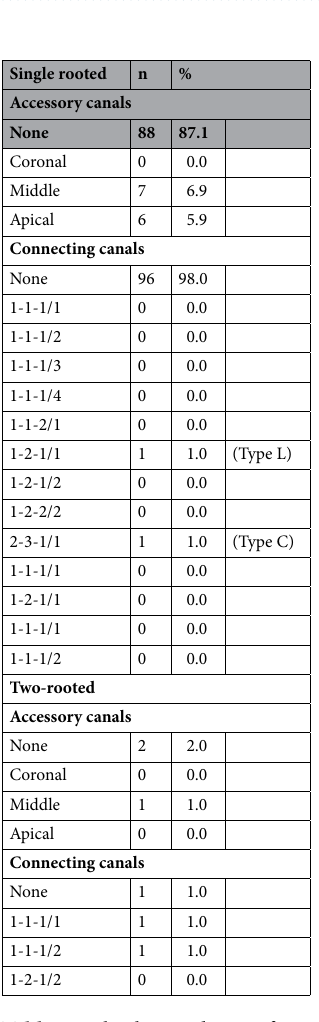
Table 3. Absolute and mean frequency of connecting and accessory canals in the coronal, middle and apical root thirds of single-rooted (n = 98) and two-rooted (n = 3) mandibular canines (n =